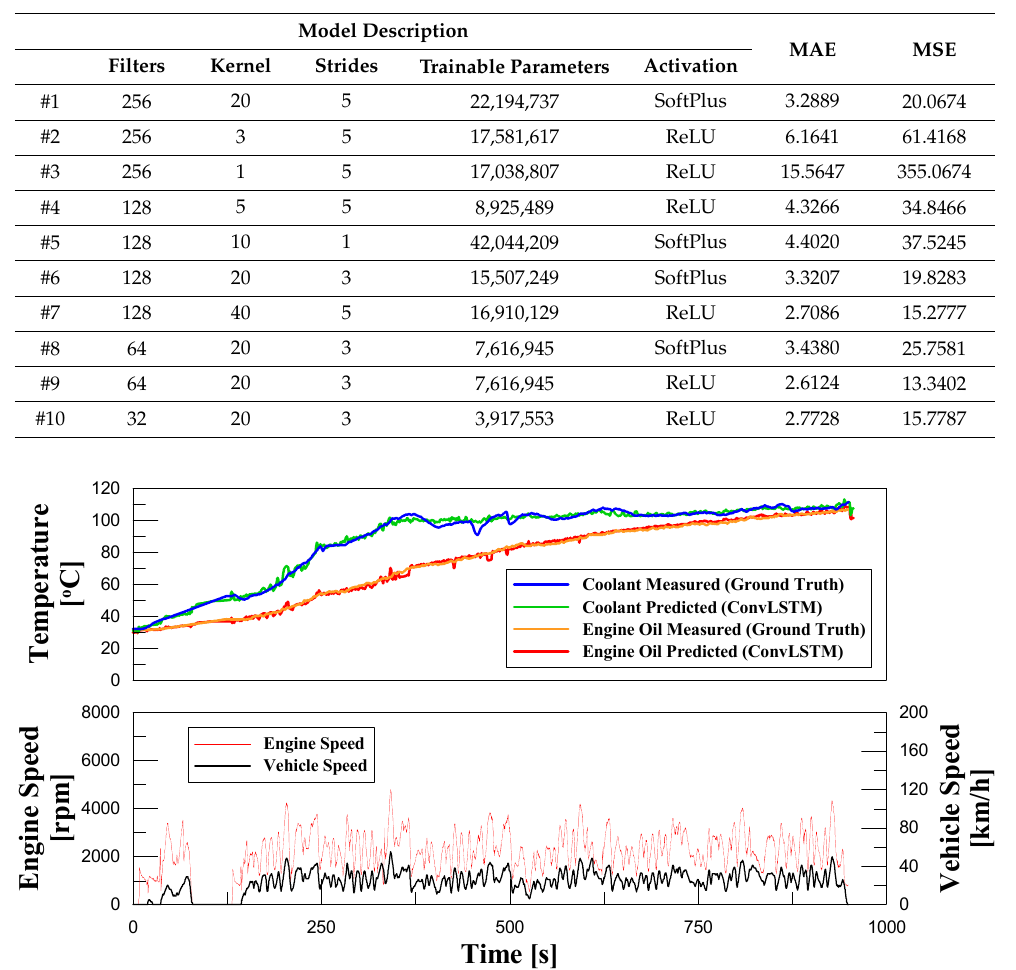
Table 4. Parameter optimization for ConvLSTM models.